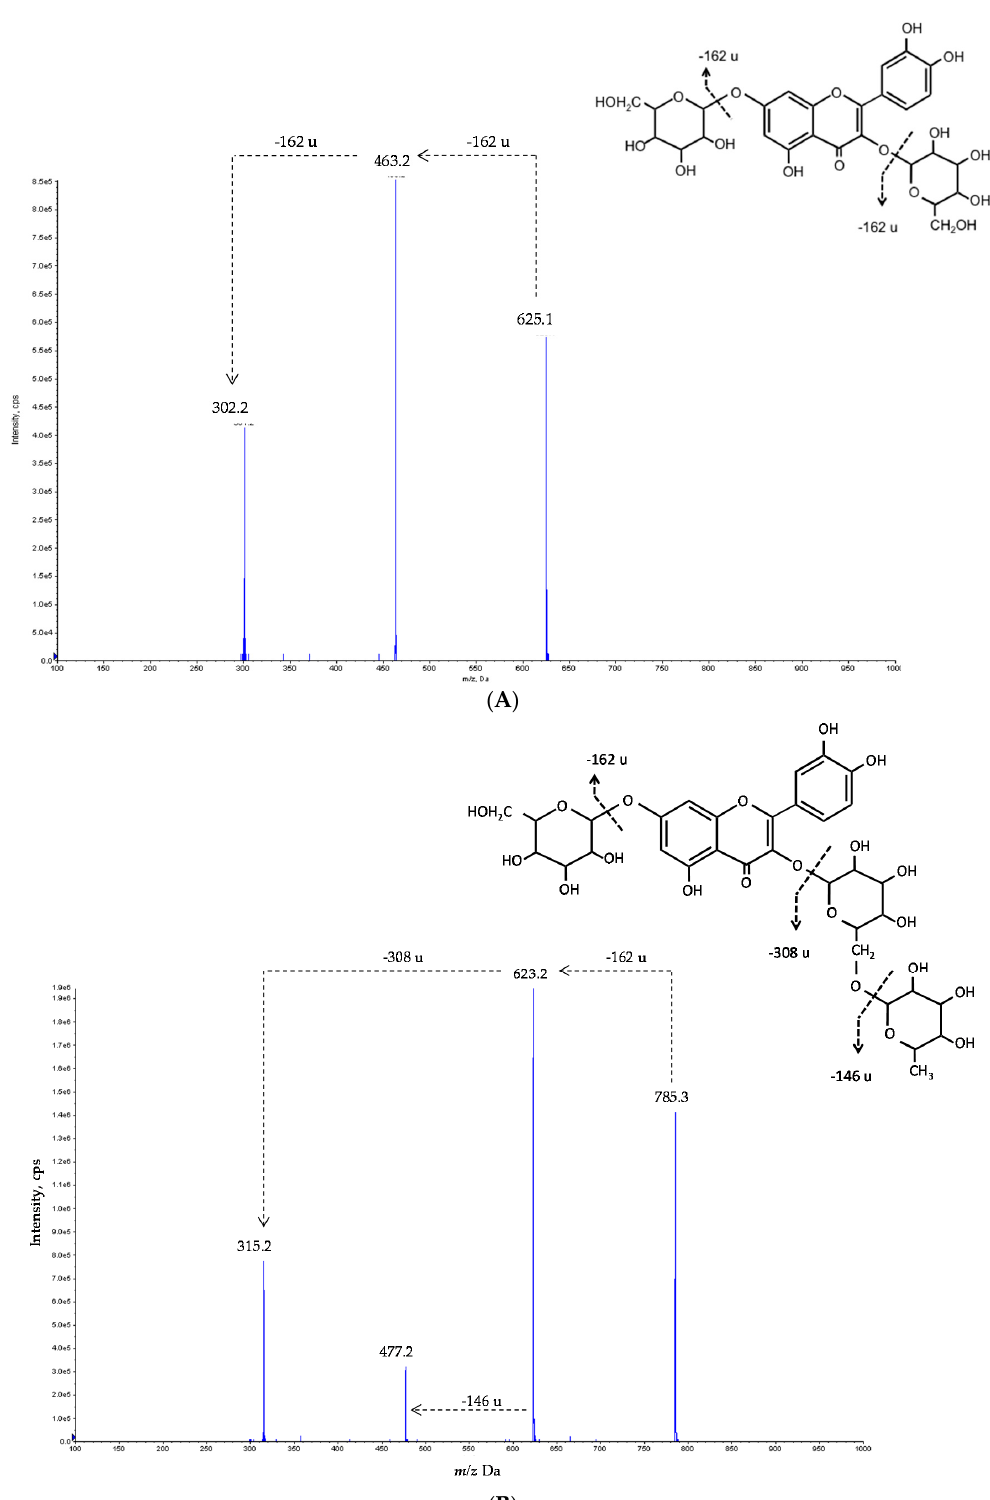
Figure 3. Fragmentation pattern of: ( A ) quercetin-3- O -glucoside-7- O -glucoside (possible identification for compound 4 ) and ( B ) isorhamnetin-3- O -rutinoside-7- O -glucoside (possible identification for compound 5 ).